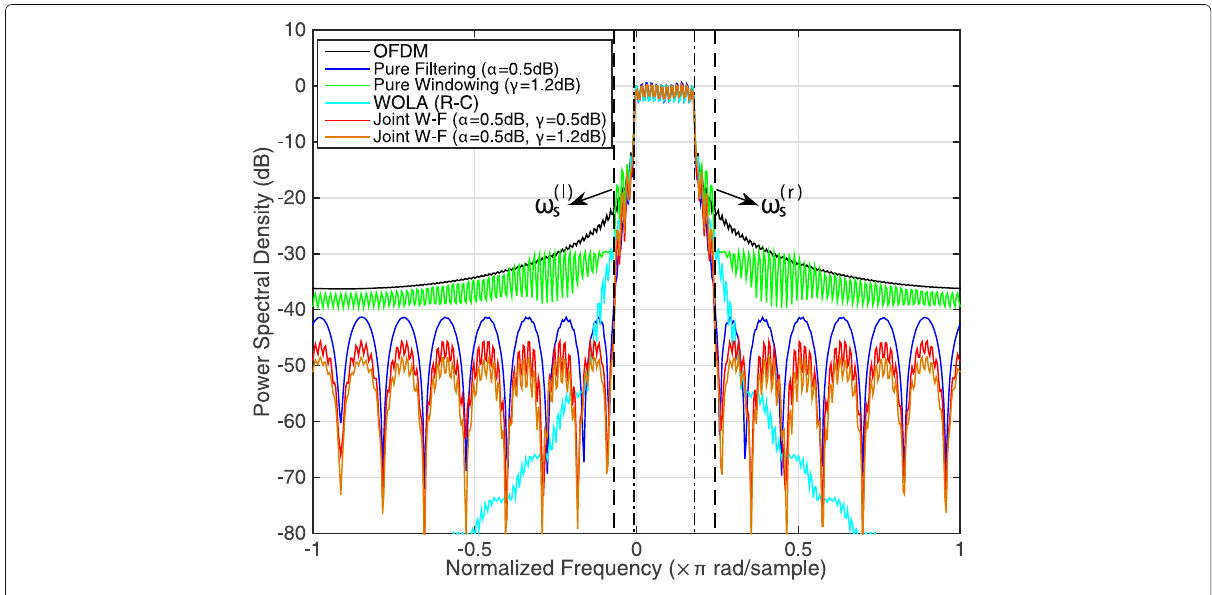
Fig. 7 PSD of various types of waveforms ( η =